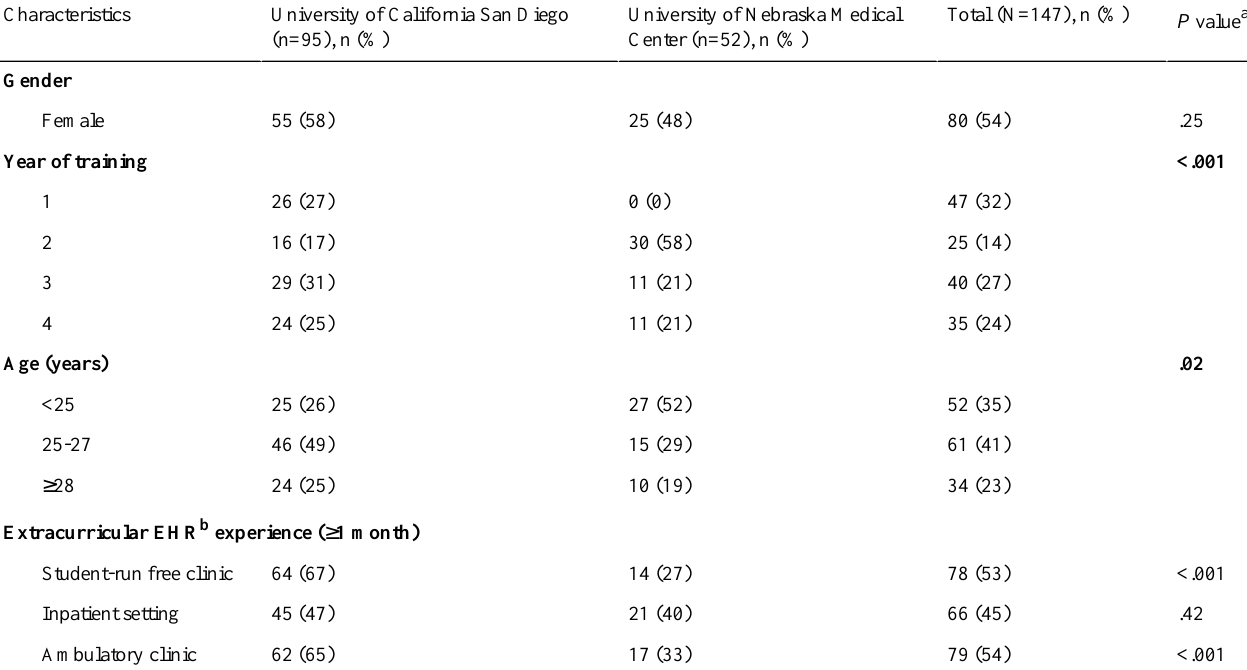
Table 1. Characteristics of medical students from the University of California San Diego School of Medicine and the University of Nebraska Medical Center College of Medicine responding to a survey on self-perceived electronic health record